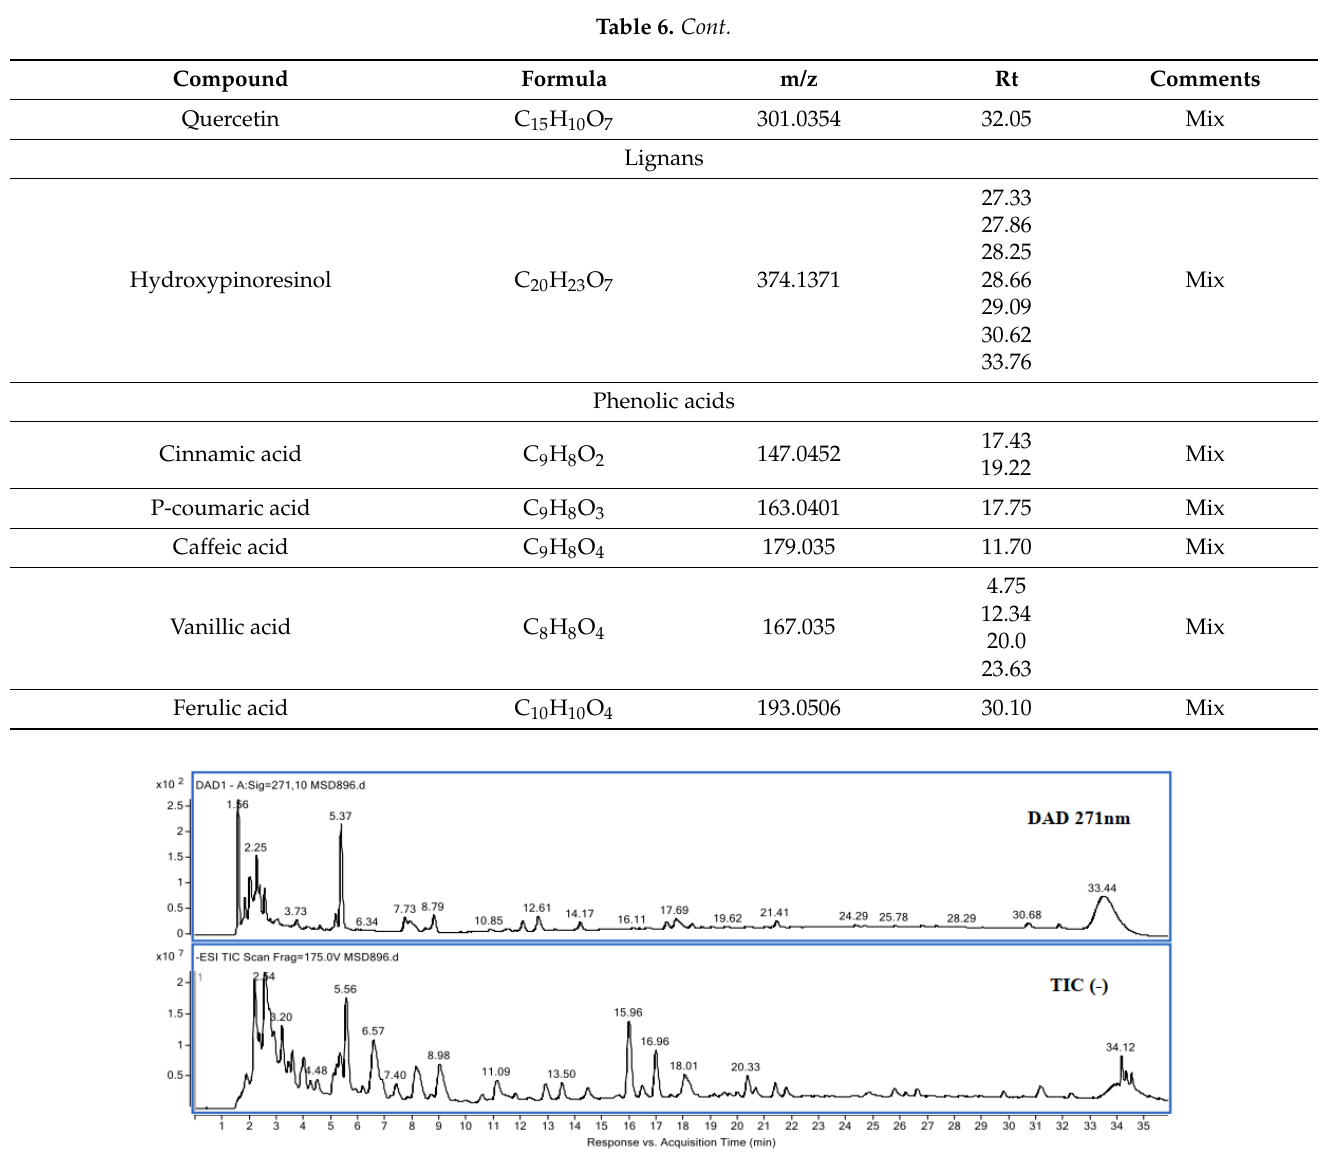
Figure 5. UV chromatogram (DAD) and ion chromatogram (TIC) ESI-TOF (-) Frag. 175V.